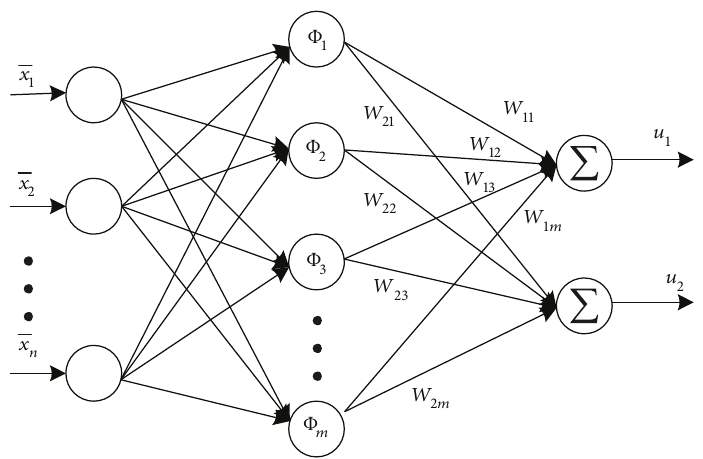
Figure 1: The structure of a radial basis function network in